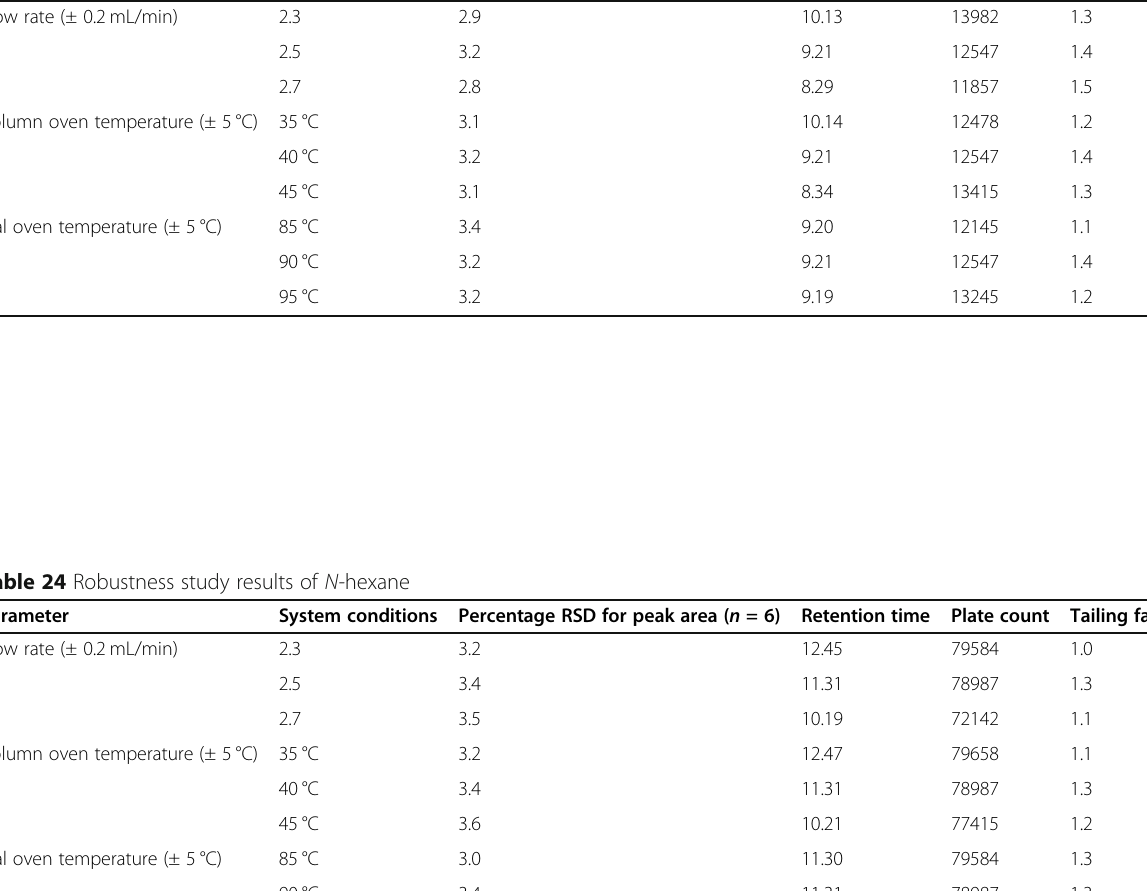
Table 23 Robustness study results of dichloromethane Parameter